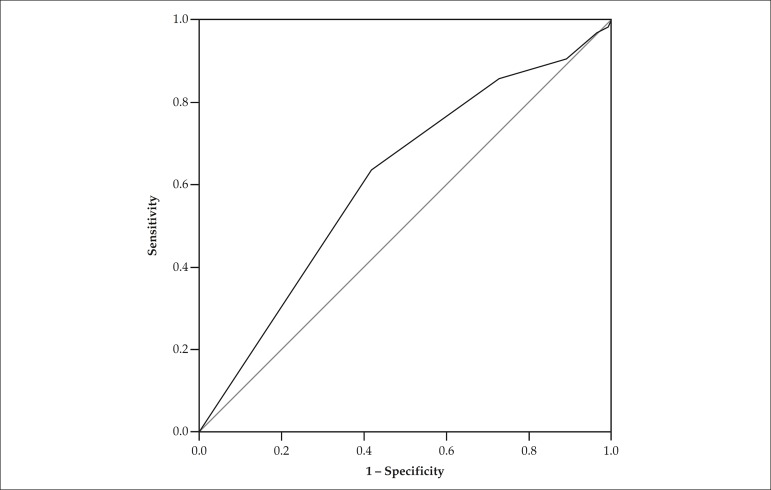
ROC curve for the outcome 'TTR ≥ 65%'.